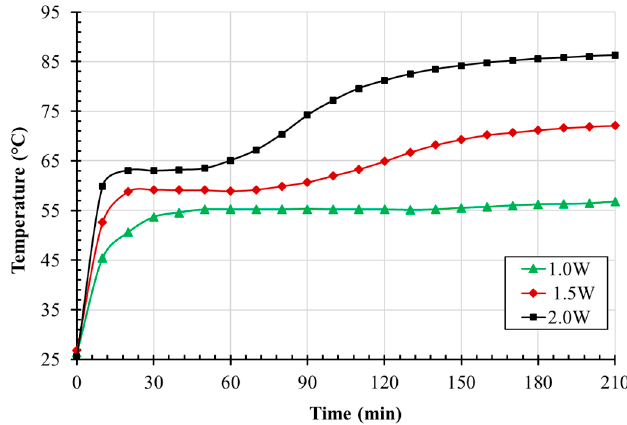
Figure 4. Heat sink surface temperature using RT47 for three different power ratings.